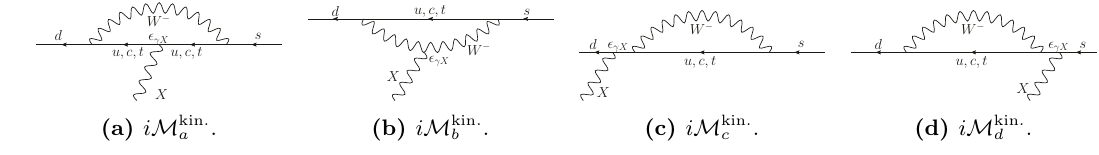
Figure 2. The diagrams which contribute to the loop-induced dsX FCNC process only with the kinetic mixing (cid:15) (cid:13)X between X boson and SM photon. In 0 t Hooft-Feynman gauge, the charged goldstone boson (cid:30) (cid:0) contributions also should be